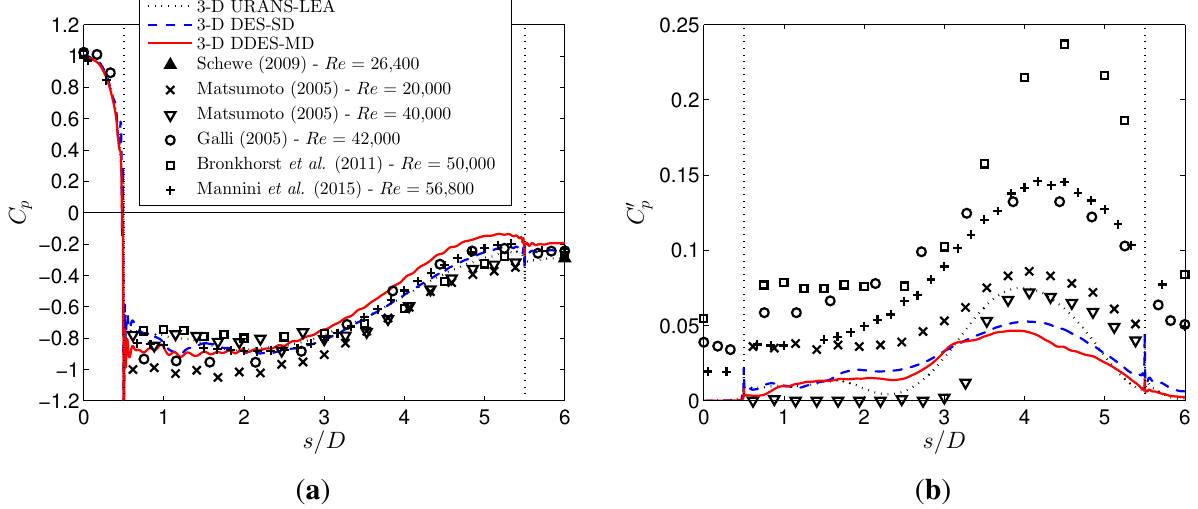
Figure 14. Mean ( a ) and standard deviation values ( b ) of the pressure coefficients along the contour of the cross-section of the rectangular 5:1 cylinder. Experimental results from